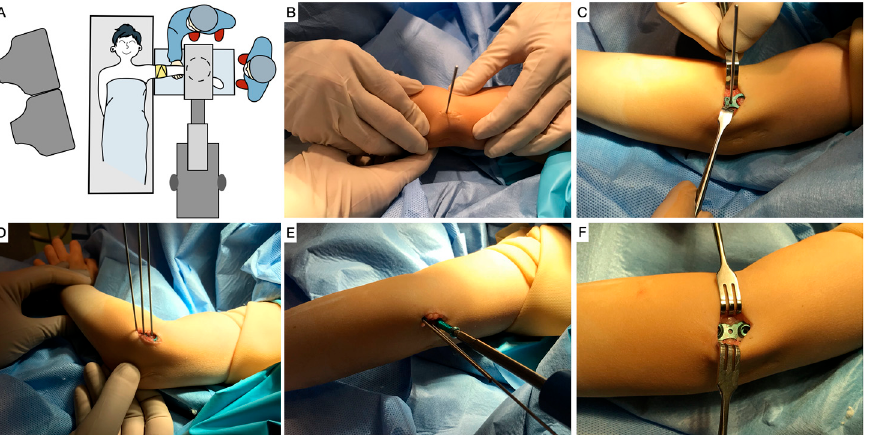
Figure 1. ( A ) Operating room layout with the patient in a supine position and the affected arm on radiolucent hand table. The patient’s shoulder is centered, in 90° of abduction and internal rotation and the elbow is flexed at 60–70° with the forearm in pronation. The image intensifier is set up from the bottom and screens are placed in front of the surgeon. The tourniquet is placed on the upper arm with a sterile Esmarch bandage. ( B ) Guide wire located in the lateral humeral condyle physis under fluoroscopic guidance and 2 cm incision centered over the guide wire. ( C , D ). Placement of eight-Plate and two more guide wires, proximal and distal. ( E ) Cannulated screw placement. ( F ) Intraoperative result after placement of the eight-Plate and screws in the lateral distal humerus.